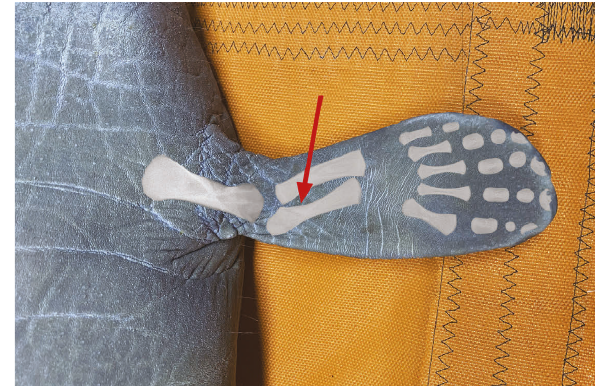
Figure 2: Location for venipuncture (red arrow) between the radius and ulna of the palmar section of the flipper of an Antillean manatee. Arm and hand bones overimposed graphically from an x- ray of the same